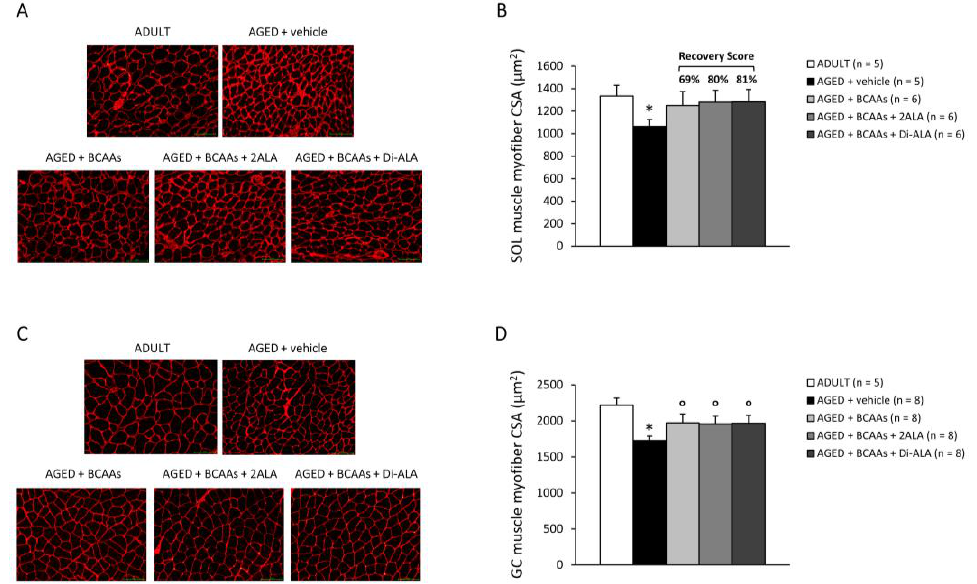
Figure 3. ( A ) shows representative SOL muscle sections (20 × magnification) stained by immunofluo- rescence (IF) for laminin for each experimental group (ADULT mice and AGED mice treated with vehicle, BCAAs, BCAAs + 2ALA or BCAAs + Di-ALA). ( B ) shows the mean cross-sectional area (CSA, µ m 2 ) for all fiber types ± SEM, obtained from the number of mice indicated in brackets. Representative images for GC muscle (20 × magnification) and mean CSA values ± SEM are shown in ( C , D ), respectively. For both muscles, a statistically significant difference was found via an unpaired Student’s t-test for AGED + vehicle vs. ADULT mice (*; 0.003 < p < 0.04). For SOL muscle, no statistically significant differences were found among AGED groups via a one-way ANOVA followed by Dunnett’s post hoc test. The recovery scores for ADULT values, calculated for each treated group, is indicated above the bars. For GC muscle, a statistically significant difference among AGED mice groups was found via a one-way ANOVA (F = 3.4, p < 0.03). Dunnett’s post hoc test is as follows: ◦ vs. AGED + vehicle ( p < 0.03).